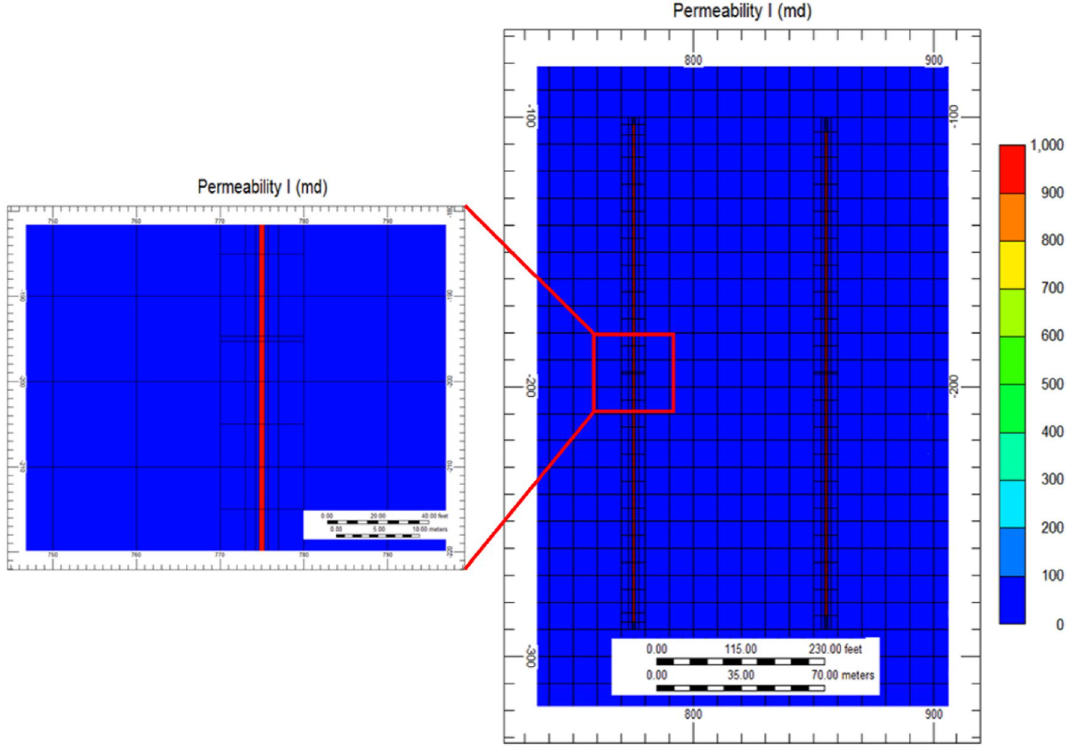
Fig. 2 Enlarged zone with LGR used to model hydraulic